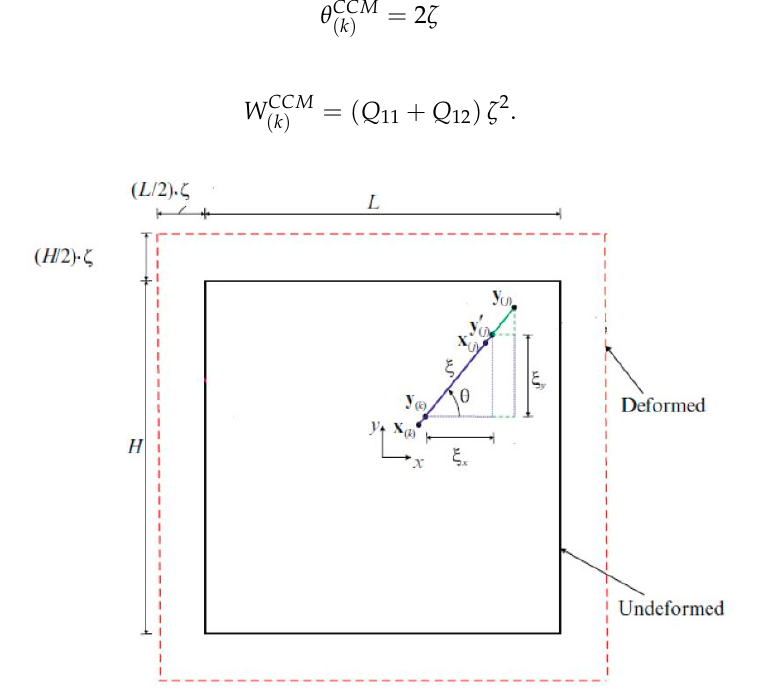
Figure 5. Biaxial stretch loading condition.